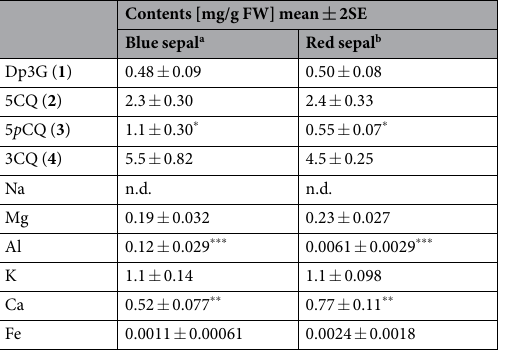
Table 1. Content of organic and inorganic components in sepal tissues of blue and red hydrangea. a n = 5 for analysis of 1–4 and n = 8 for analysis of inorganic elements. b n = 3 for analysis of 1–4 and n = 6 for analysis of inorganic elements. Significant differences were observed between the same marks as * p < 0.05, ** p < 0.01, and *** p < 0.001. Dp3G: 3- O -glucosyldelphinidin, 5CQ: 5- O -caffeoylquinic acid, 5 p CQ: 5- O - p -coumaroylquinic acid, 3CQ: 3- O -Caffeoylquinic